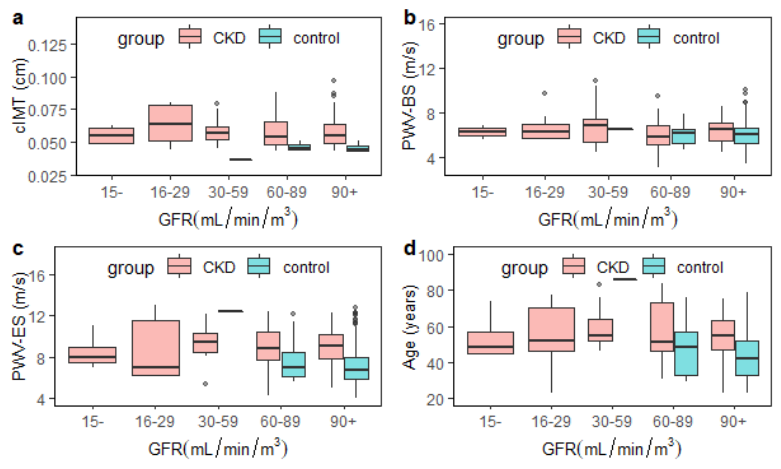
Figure 1. Box plot shows relationship of (a) carotid intima-media thickness (cIMT), (b) pulse wave velocity-beginning of systole (PWV-BS), (c) pulse wave velocity-end of systole (PWV-ES), (d) age with glomerular filtration rate